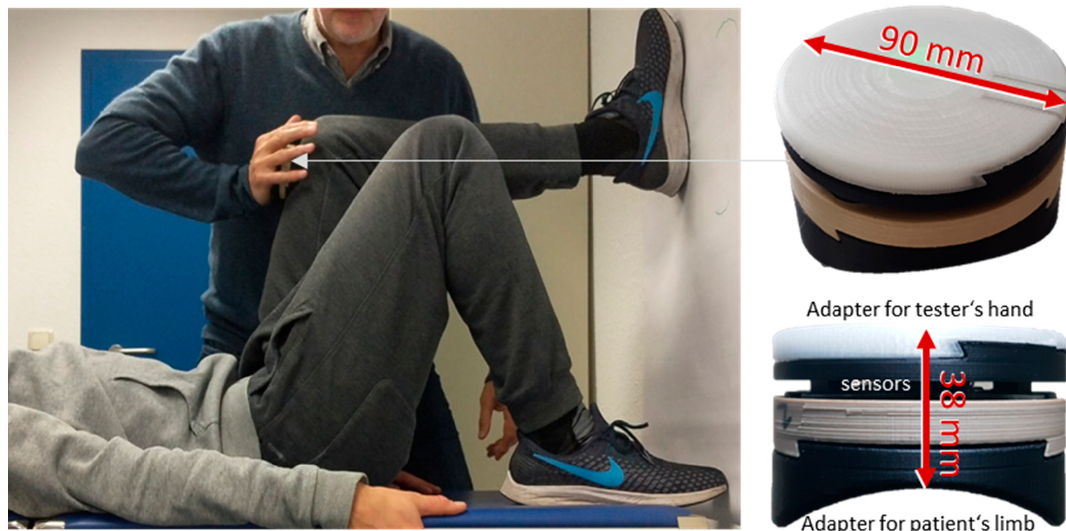
Figure 1. Setting of the manual muscle test (MMT) of the hip flexors with fixed leg including the handheld device. The assistant’s leg is fixed against the wall to ensure a stable position also after repeated trials. The tester’s forearm is in a rectangular position to the rectus femoris muscle. The handheld device is located between the tester’s hand and the assistant’s distal thigh to measure the force profile produced by the tester. On the right side, the handheld device with two adapters is illustrated: one for the palm of the tester (white) and one for the limb of the patient (black), which is shaped according to the contours of the limb. Between the adapters, the sensor technology is placed. Dimensions of the handheld device are given in mm.